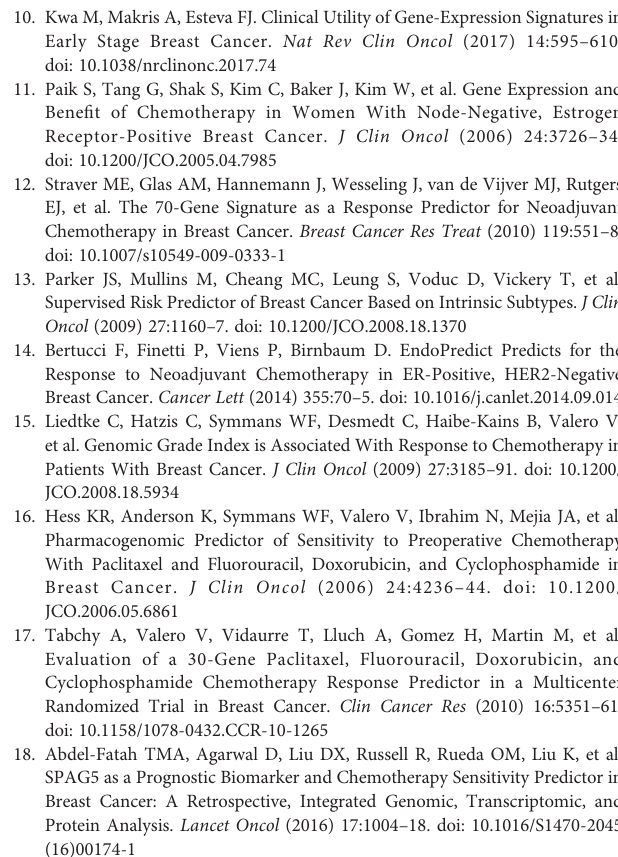
Supplementary Figure 1 | The work fl ow of this study. Supplementary Figure 2 | Hierarchical clustering dendrograms of the expression patterns of 25 DEGs in all datasets. DEGs, differentially expressed